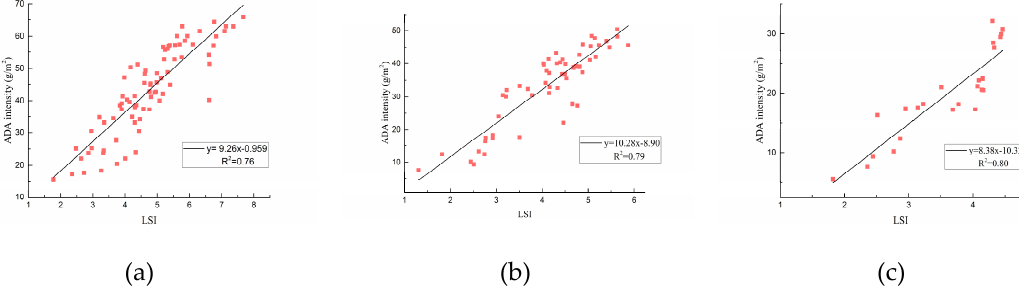
Figure 12. Relationship between ADA intensity and landscape shape index (LSI) of ( a ) PA = 3 ha, ( b ) PA = 7 ha, and ( c ) PA = 12 ha of woodland.